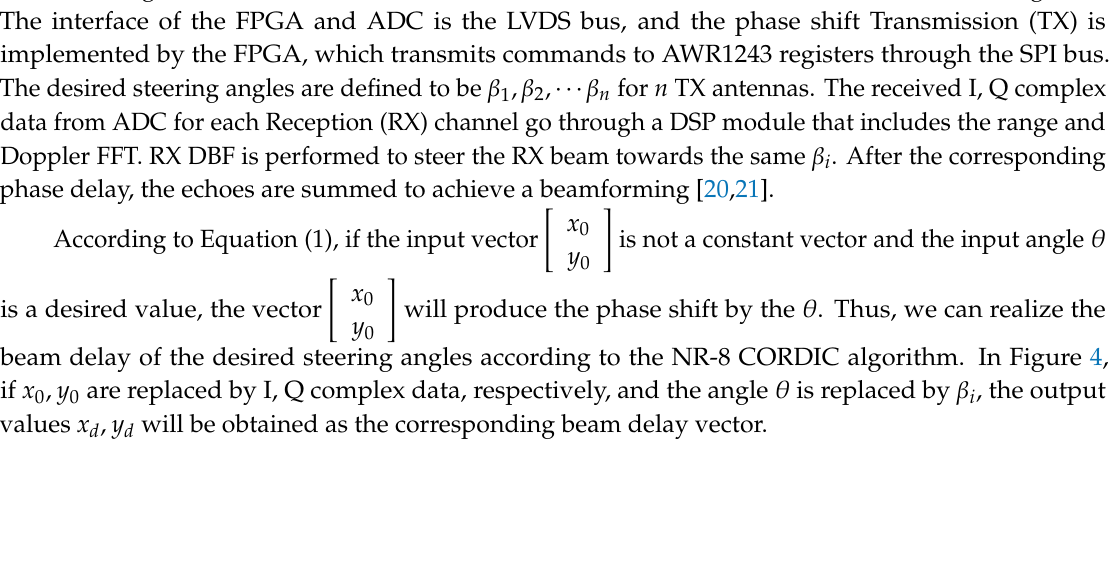
Figure 7. The relations between root mean squared errors (RMSEs) and the input bit width M of the NR-8, R-8, R-4 and R-2 CORDIC algorithms. The angles θ change from 0 to 90° in steps of 1, 0.1, 0.01 and 0.001°.